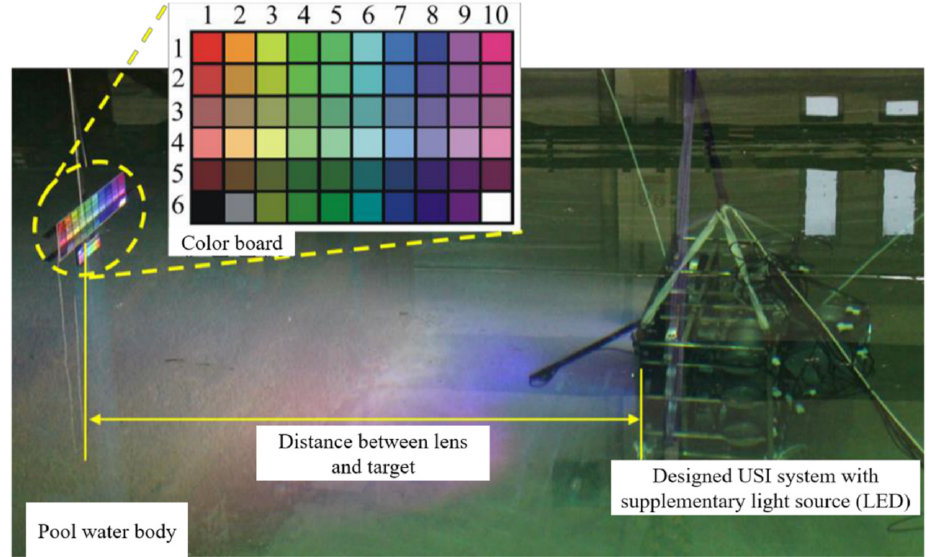
Figure 11. Observing color plate by USI system under supplementary illumination during pool